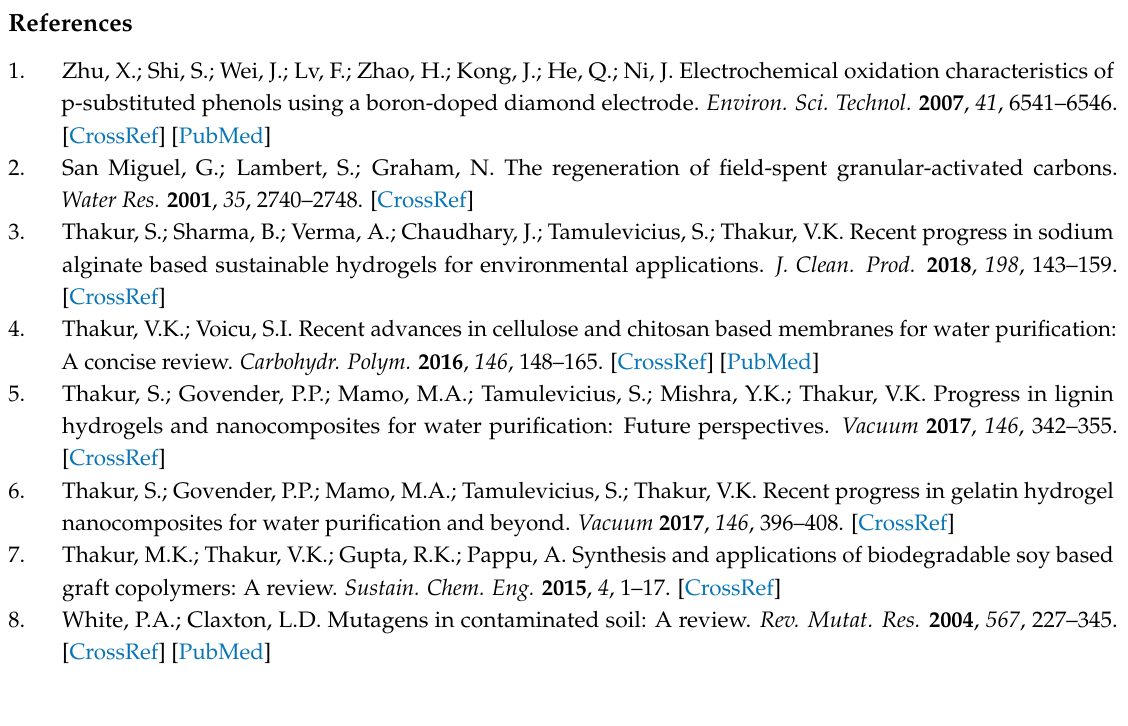
s1, Figure S1: Recovery percentage (%) of PAHs from Bz-Cell, St-Cell, and activated carbon by MeOH, Figure S2: Recycling of Bz-Cell and St-Cell for the removal of phenanthrene and pyrene up to 10th cycles, Figure S3: Removal efficiency (%) of phenanthrene and pyrene by activated